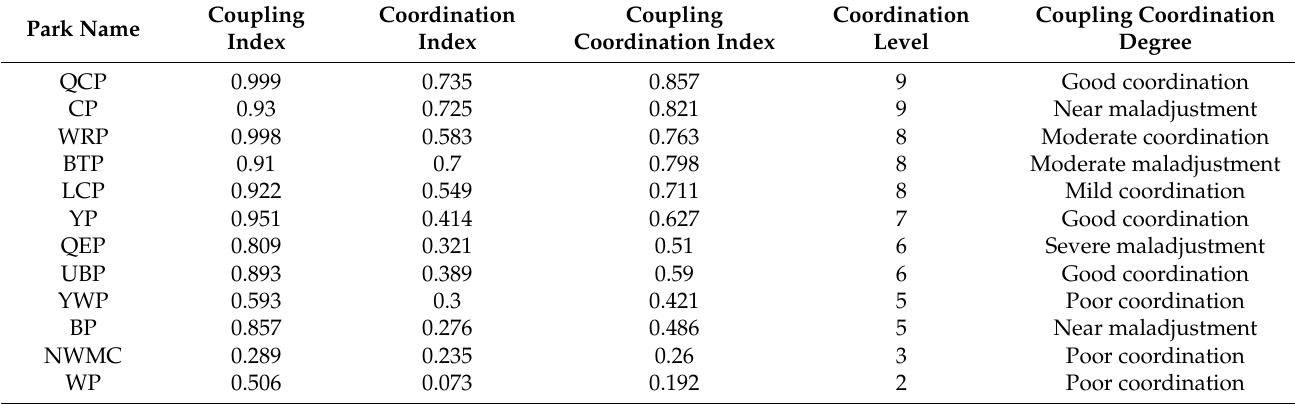
Table 11. Psychological–behavioral dimension coupling coordination